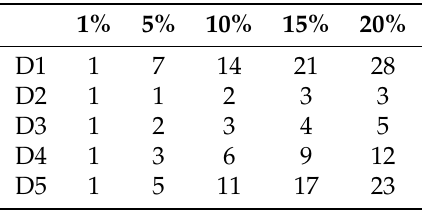
Table 2. Average number of labeled instances per class for each